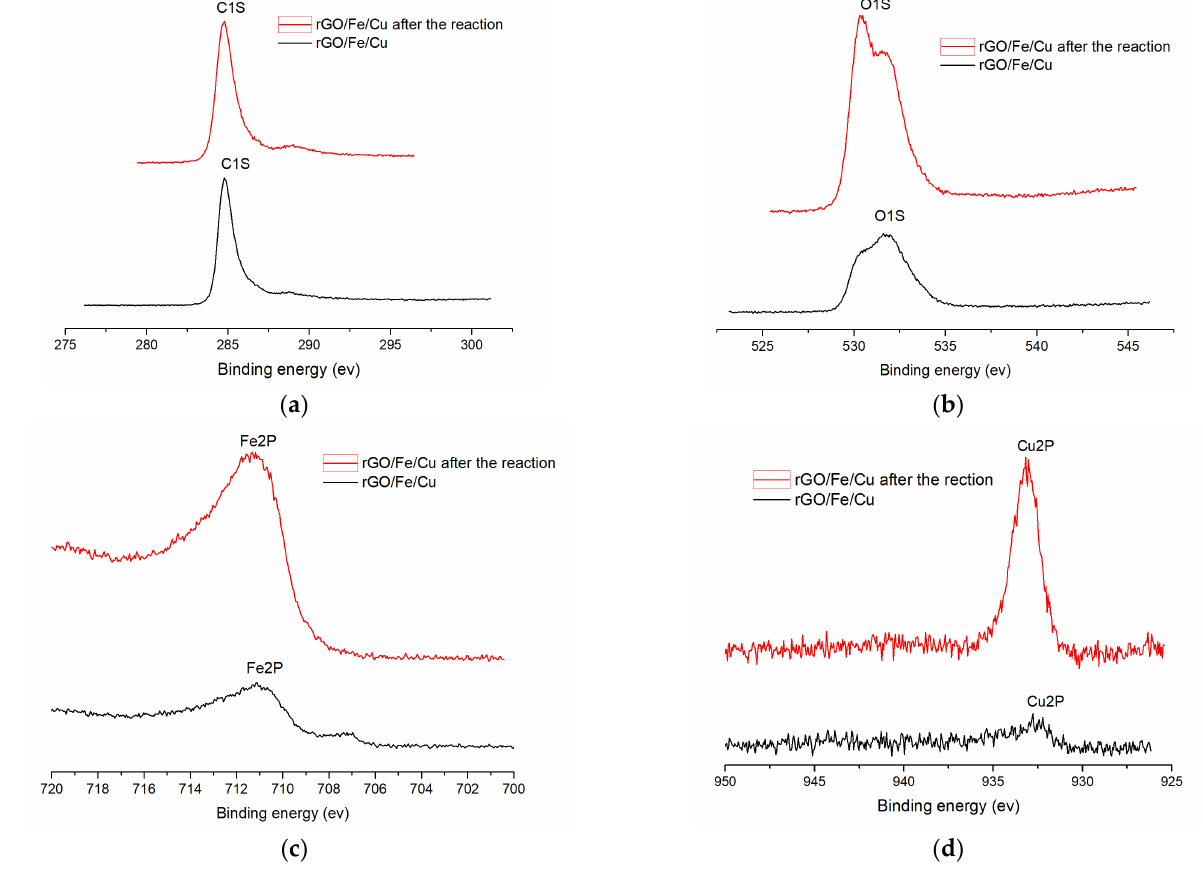
Figure 14. Photoelectron spectra of ( a ) C(1S); ( b ) O(1S); ( c ) Fe(2P) and ( d ) Cu(2P) before and after removing carmine by rGO/Fe/Cu.